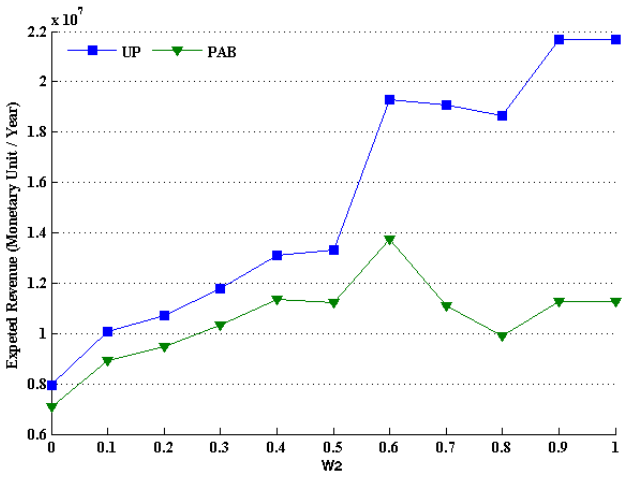
Figure 5. Expected revenue of Khaf 18-MW wind farm weighting factors.